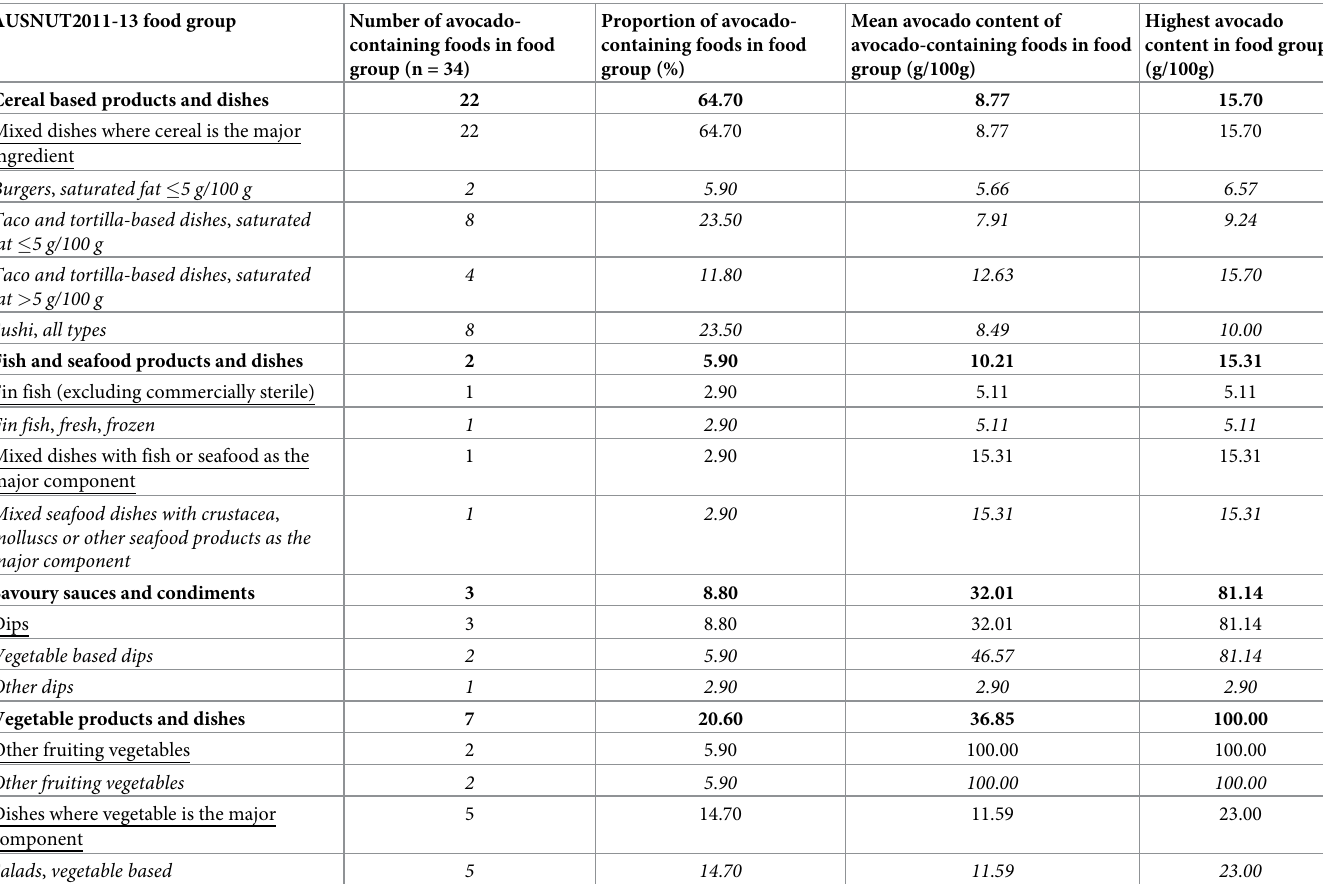
Table 1. An overview of the avocado content (grams avocado per 100 g food) at food group levels � in which avocado-containing products were